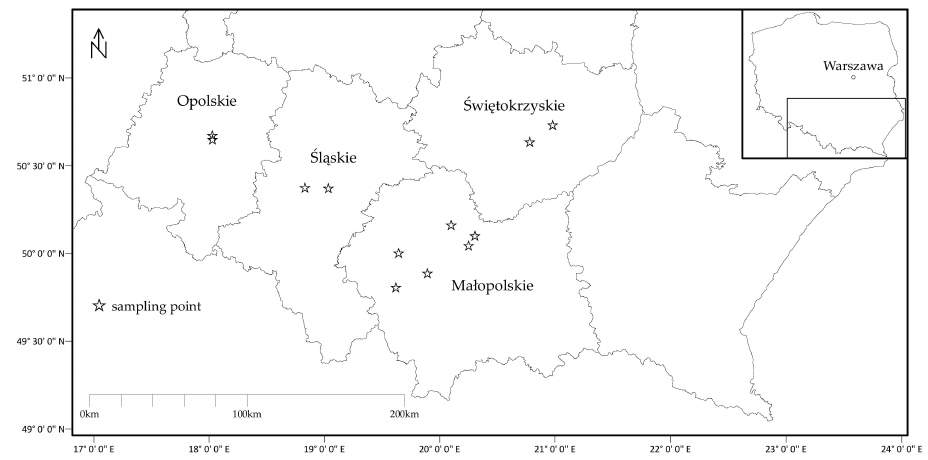
Figure 1. Vegetable sampling site locations in the Regions of southern Poland (modified from